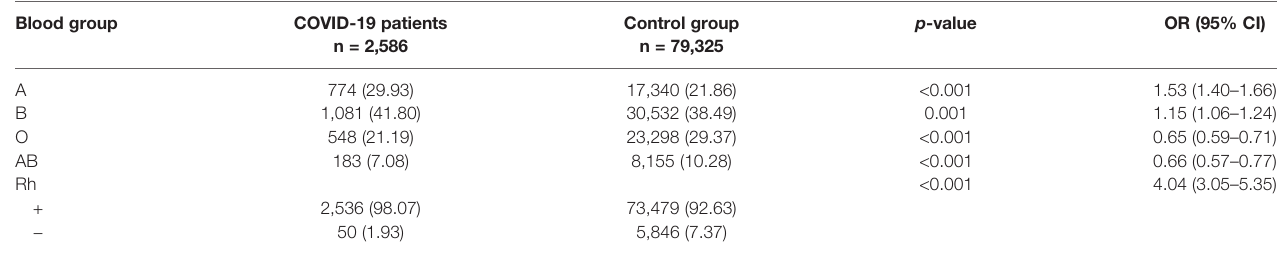
TABLE 1 | Distribution of ABO and Rh blood groups among controls group and COVID-19-infected patients. Blood group COVID-19 patients